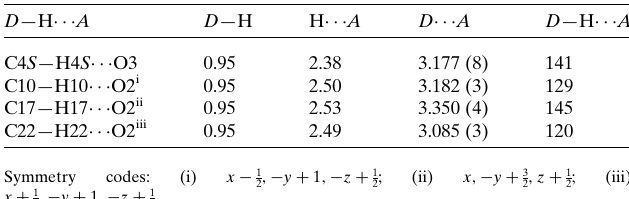
Table 2 Hydrogen-bond geometry (A˚ , (cid:4) ).